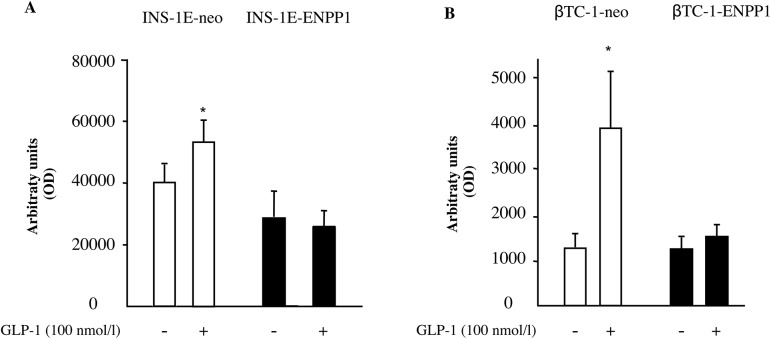
GLP-1 fails to increase cell proliferation in ENPP-1 transfected cells.Proliferation was assessed by BrdU incorporation in INS-1E (panel A) and βTC-1 (panel B) cells, either transfected with neo or ENPP-1 gene variant. Cells were starved for 12 hours and then incubated for 48 hours in the absence or presence of 100 nmol/l GLP-1. Values are means ± S.D. of four independent experiments. * p<0.05 for INS-1E and for βTC-1 compared with untreated INS-1E-neo or βTC-1-neo cells.